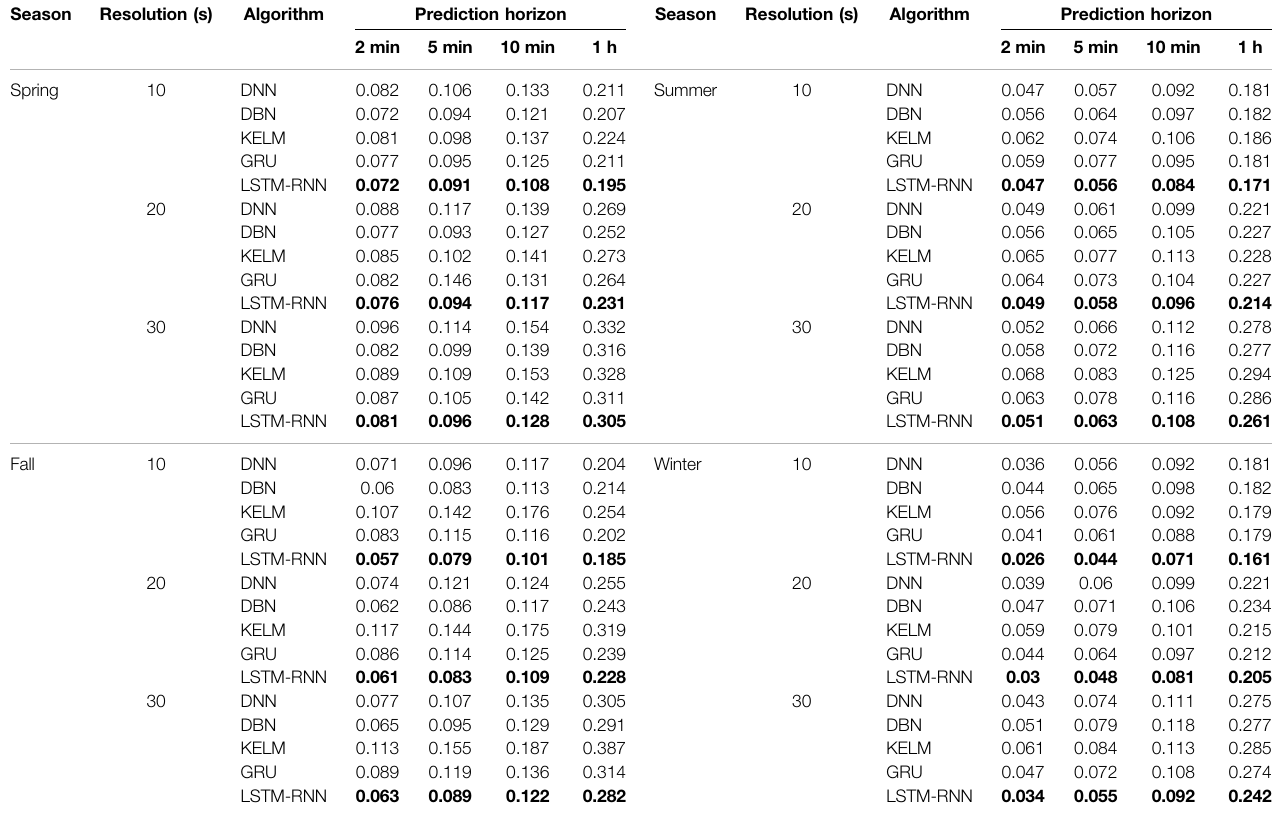
TABLE 2 | Mape of the fi ve algorithms for 2020 after error correction. Season Resolution (s) Algorithm Prediction horizon Season Resolution (s) Algorithm Prediction horizon